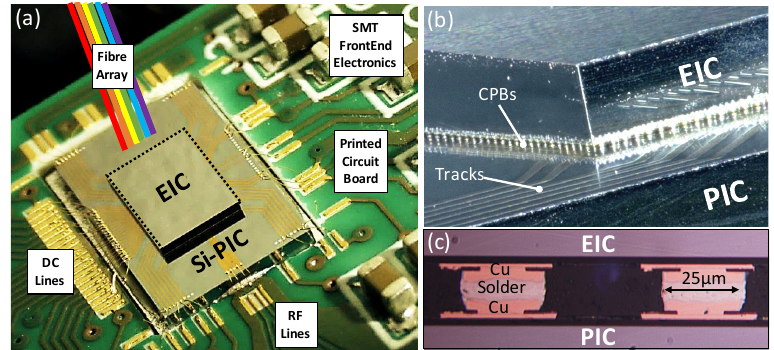
Figure 12. Vertical integration of an electronic integrated circuit (EIC) driver-chip on top of a Si-PIC; ( a ) Image of an EIC integrated on a PIC, with RF (radio frequency) and DC (direct current) signals routed from the front-end electronics on the PCB across the surface of the PIC; ( b ) Microscope image of the EIC integrated onto the PIC using several hundred discrete copper-pillar-bumps (CPBs); ( c ) Further zoomed-in microscope image of the CPB interconnects between the EIC and PIC. Solder reflow bonding with a “no clean” flux allows for very well aligned CPB interconnects with minimal “solder squeezing”.